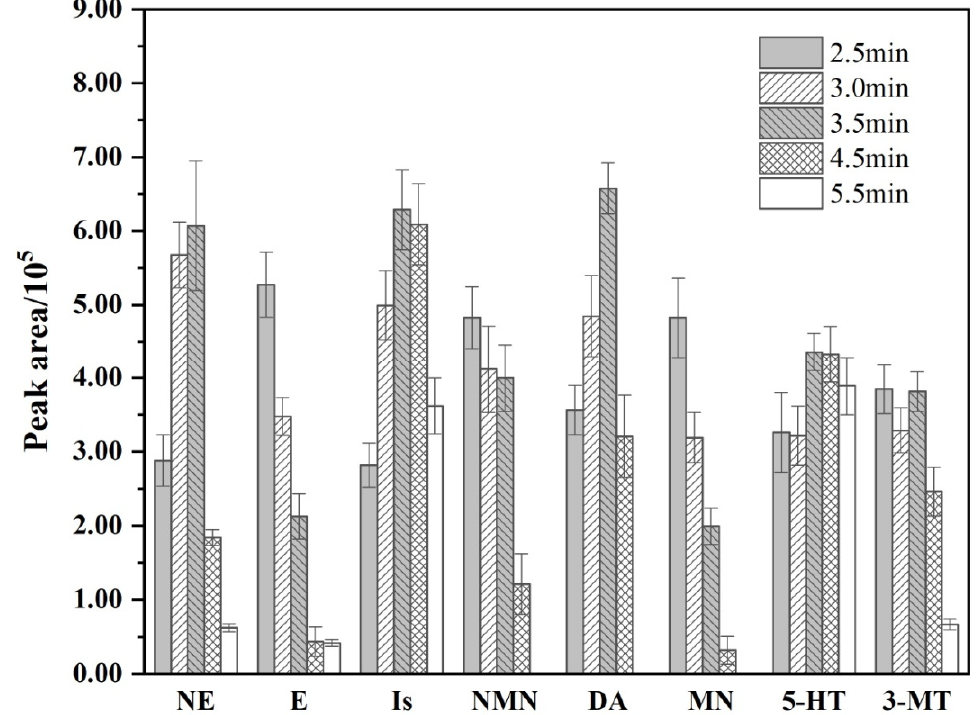
Figure 2. Comparison of peak area of the biogenic monoamines at different durations.